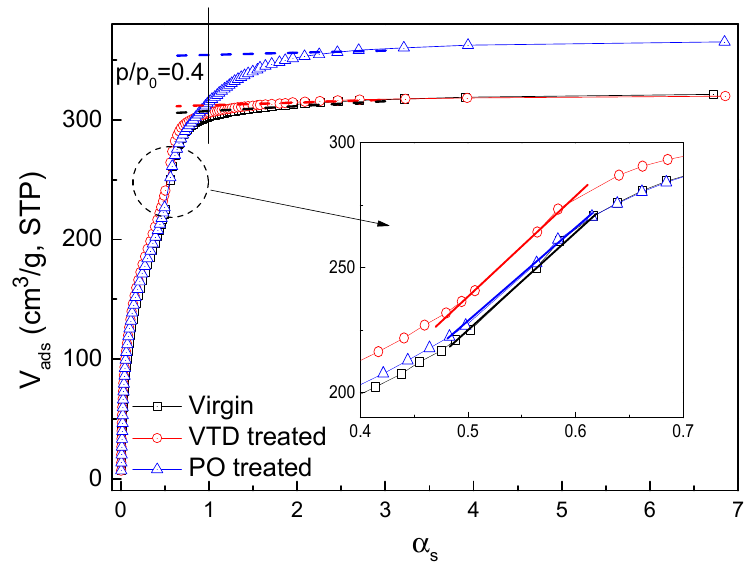
Figure 2. High-resolution α s –plots of N 2 at 77.4K for virgin, VTD-treated and PO-treated GAC samples.